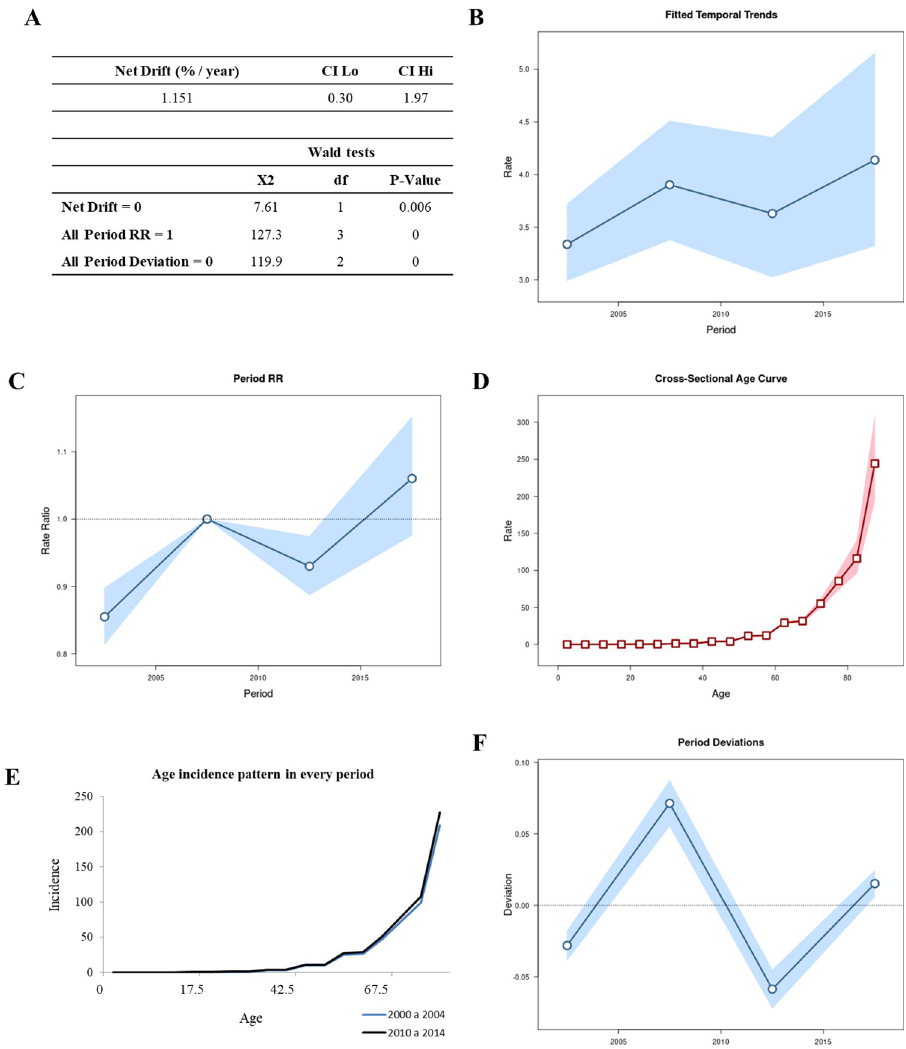
Fig 2. Age-period-cohort analysis using the Wald test, with the analysis of net drift (A), temporal trends (B), period rate ratios (C), the cross-sectional age curve (D), the age incidence pattern for every period (E), and all period deviations (F). In Fig 2B-2D and 2F the lines represent the oscillation of the Y-axis value in relation to the X-axis; the circle or square represents the moment on the X-axis; the shadows above the lines represent the 95%